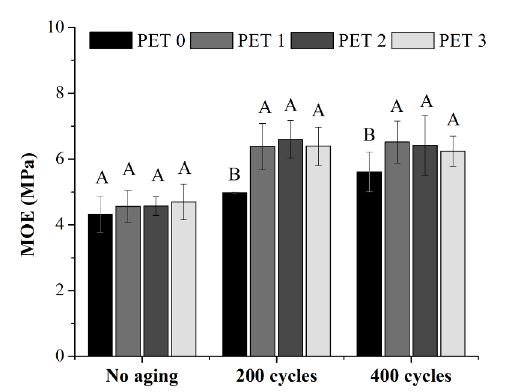
Figure 8. Average and standard deviation values of specific energy of fiber cement produced with PET particles. Consecutive means of the same letter do not statistically differ by the Scott-Knott mean test, at 5% of significance. PET1= 20 to 24 mesh, PET2= 24 to 32 mesh and PET3 = 32 to 35